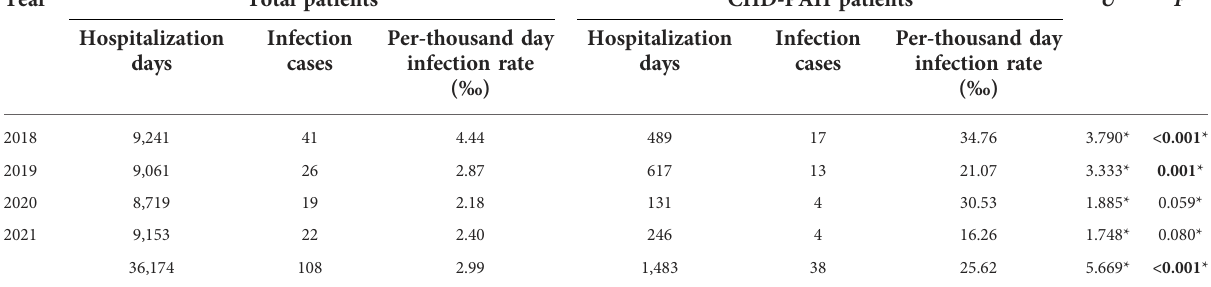
TABLE 2 Summary of per-thousand day infection rate of HAI.